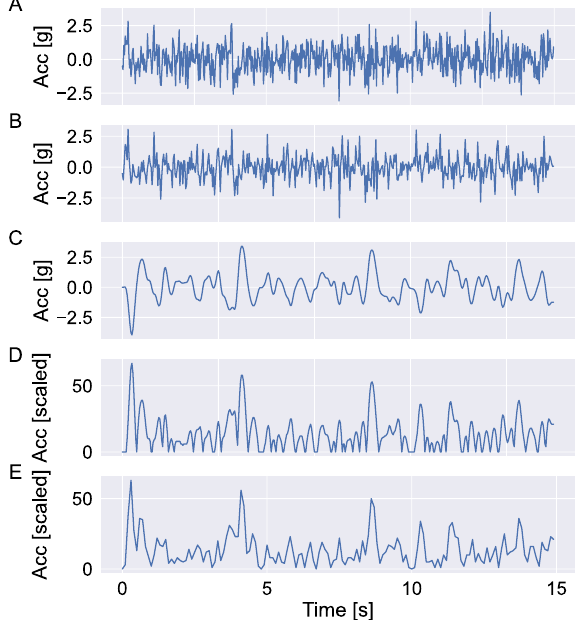
Figure 3. Example waveform and the resulting waveforms after each processing step. ( A ) The original waveform, at 40 Hz sampling rate. ( B ) The waveform down-sampled to 30 Hz. ( C ) The waveform after band- pass filtering. ( D ) The waveform scaled and rectified. ( E ) The waveform down-sampled to 10 Hz.